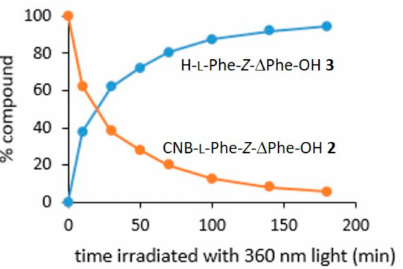
Figure 3. Conversion of compound 2 to compound 3 , under UV light (360 nm), followed by HPLC (10, 30, 50, 70, 100, 140, and 180 min irradiation). Percentages were adjusted to allow for the differences in relative response factor, using a calibration graph obtained from the analysis of authentic samples of compounds 2 and 3 (see Supporting